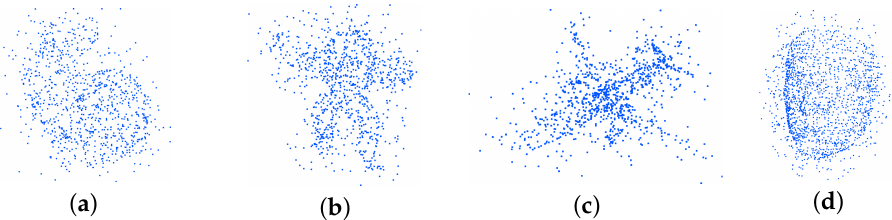
Figure 17. Point clouds with Gaussian noise, σ = 0.05: ( a ) Stanford Bunny; ( b ) Armadillo; ( c ) airplane; ( d ) human face.